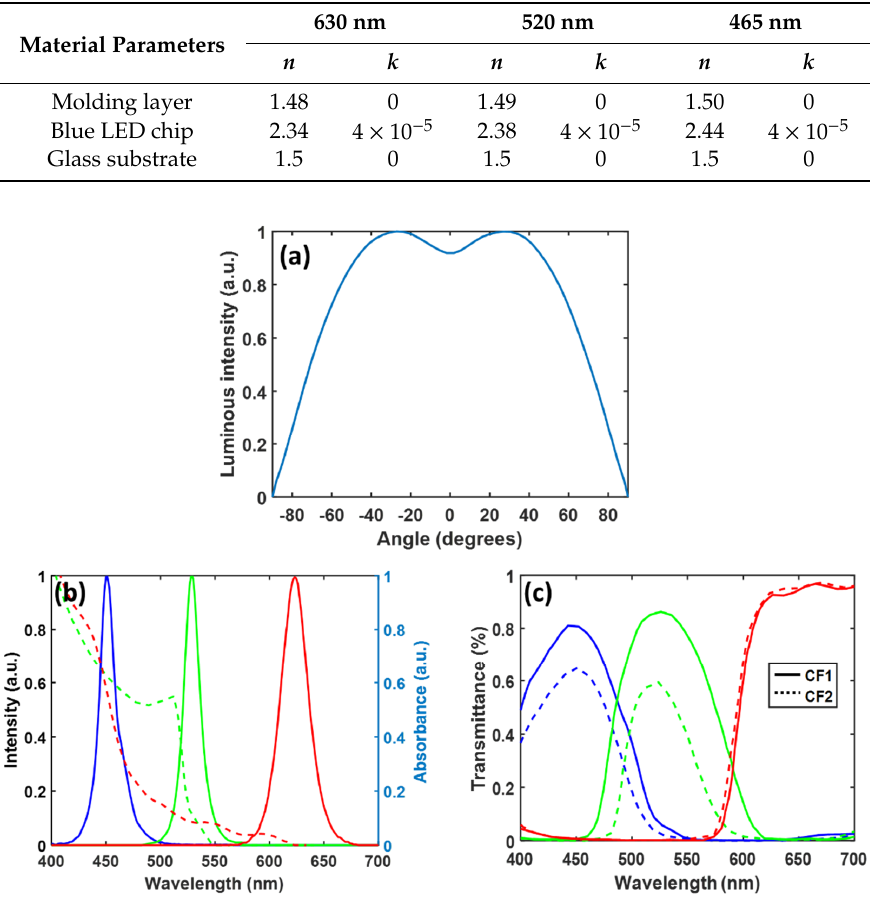
Figure 4. ( a ) Simulated radiation pattern of the micro-LED array (chip size 100 μm × 100 μm). ( b ) Emission spectrum of the blue micro-LED; absorbance (dashed lines) and photoluminescence spectra of green perovskite nanocrystal and red QD. ( c ) Transmission spectra of color filters CF1 and CF2.